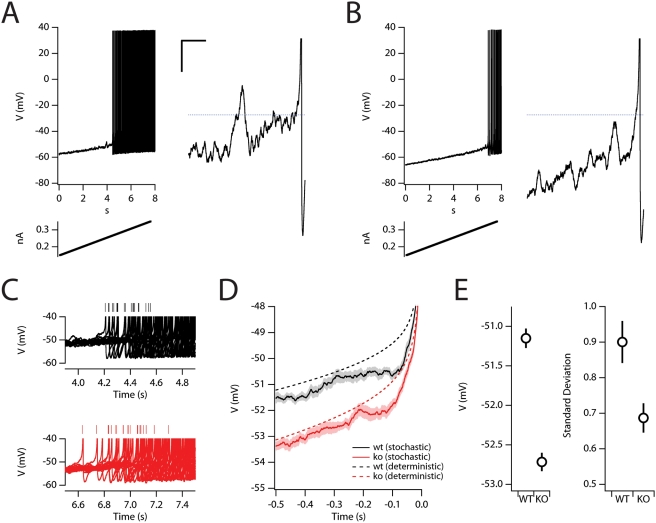
Ih enhances perithreshold stability.Example membrane potential responses (top) of the wild-type (A) and HCN1
knockout (B) model to injections of a suprathreshold ramp current
(bottom). The region indicated by the box is shown to the right on an
expanded scale. Dashed blue line is at −50 mV. Scale bars: 5
mV, 0.1 s. (C) Overlaid membrane potential response to ramp current
injection for several trials (n = 20)
for the wild-type (black) and knockout (red) models. (D) For each trial
the membrane potential was aligned to the time of the first spike. The
mean response for the wild-type (black) and HCN1 knock-out models (red)
is plotted for both the deterministic (dashed lines) and stochastic
models (solid lines). Shaded areas indicate the standard error of the
mean. (E) The mean (left) and standard deviation (right) of the
spike-triggered membrane potential from −0.5 to −0.1
s prior to the action potential.